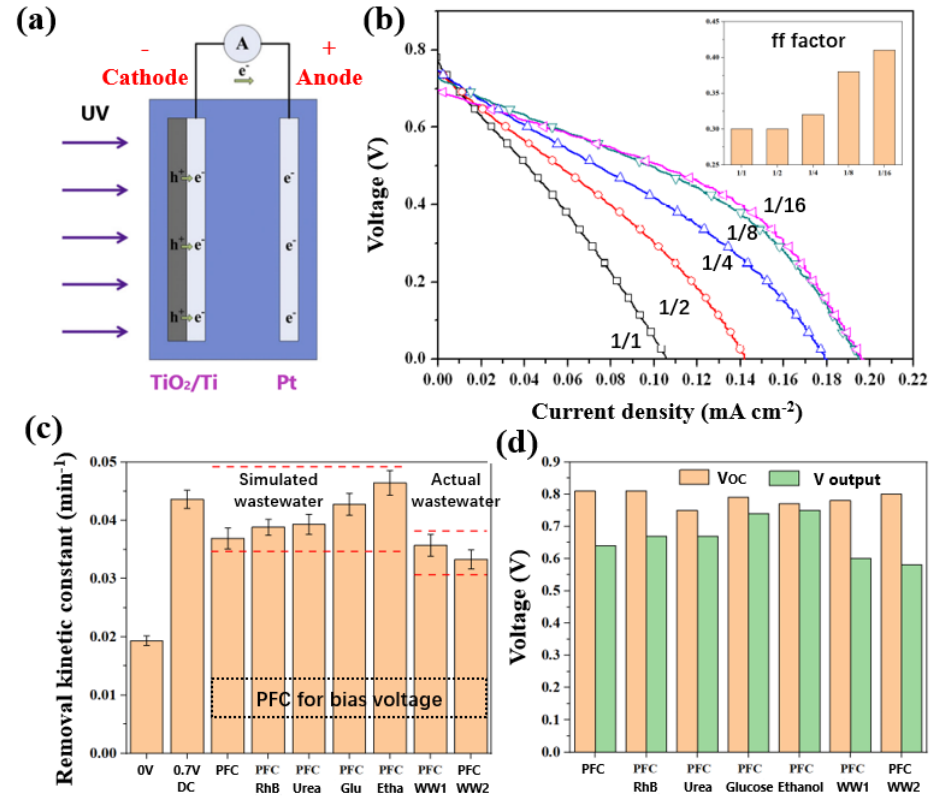
Figure 7. ( a ) Schematic diagram of TiO 2 /Ti − Pt PFC, ( b ) voltage − current curve of TiO 2 /Ti − Pt PFC with different anode area to cathode area ratio (inset is the corresponding ff factor), ( c ) RhB removal kinetic constants obtained in the presence of bias voltage and the bias voltage is applied by DC power and different PFC, and ( d ) open-circuit voltage (VOC) and the output voltage (V output) obtained by different PFCs. Reprinted/adapted with permission from Ref. [88]. 2014, ELSEVIER.